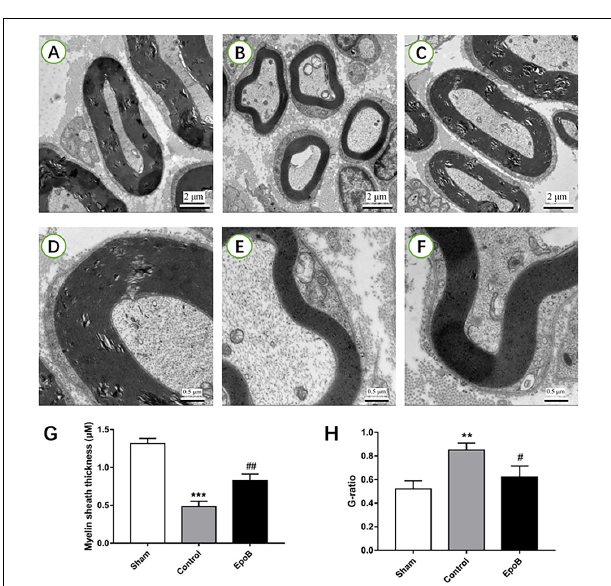
FIGURE 3 | EpoB promotes sciatic nerve remyelination after nerve injury. Representative TEM images of regenerated axons (A–C) and myelin sheaths (D–F) in the nerve segment of the sham (A,D) , control (B,E) and EpoB (C,F) groups at 4 weeks after surgery, respectively. Quantification of the average myelin sheath thickness (G) and the G-ratio (H) . Scale bars: (A–C) 2 µ m; (D–F) 0.5 µ m. ** P < 0.01 and *** P < 0.001 vs. the sham group; # P < 0.05 and ## P < 0.01 vs. the control group. Abbreviations: EpoB, epothilone B; TEM, transmission electron microscopy; G-ratio, axon/fiber